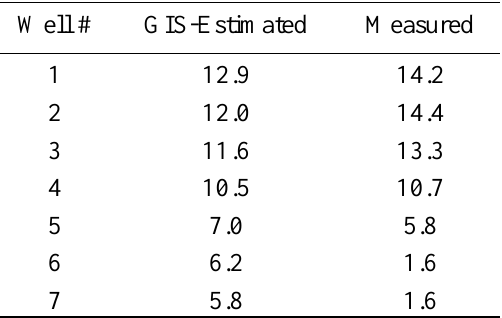
Table 1. Comparison of GIS-estimated vs. measured arsenic concentration in seven wells (μg/L).